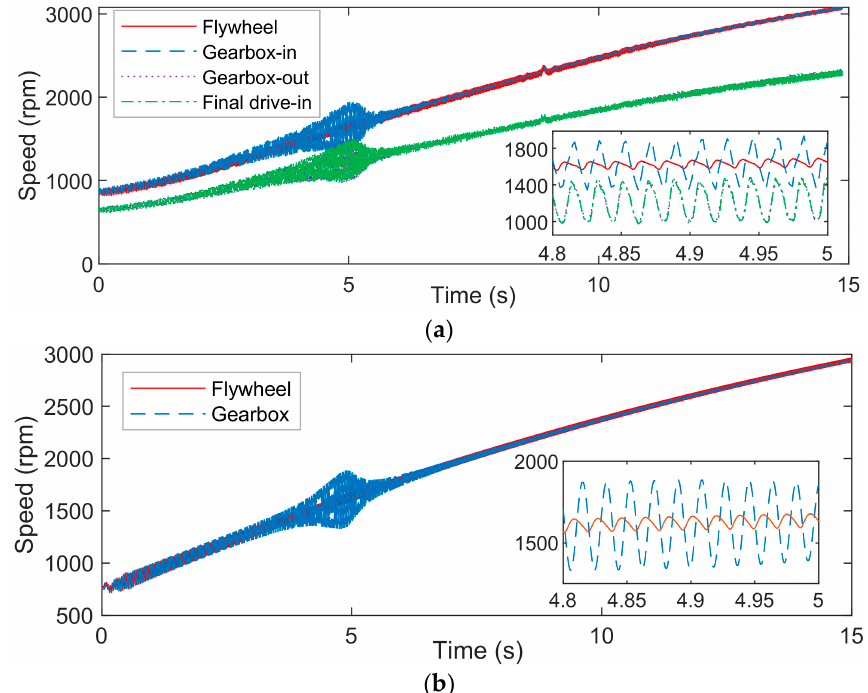
Figure 6. Measured and calculated results during vehicle accelerating with the 4th gear. ( a ) Measured speeds of the experiment; ( b ) calculated speeds of the simulation.